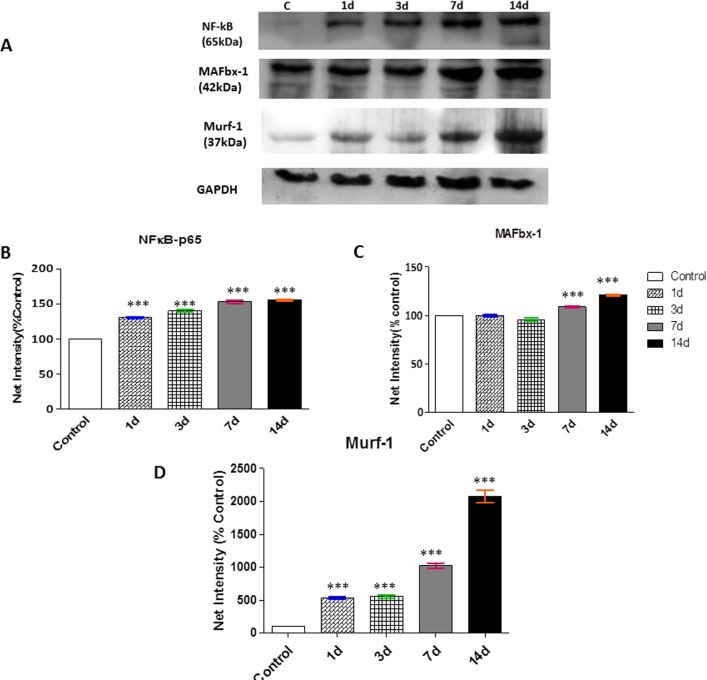
Upregulated NF-κB and E3 ligase mediated protein degradation in response to chronic hypoxia.(A) Representative western blots for expression of NF-κB and Mafbx-1 in skeletal muscles and (B—D) Semiquantitative analysis of the expression of NF-κB, MAFbx-1and MuRF-1 is presented in the graph. The densitometric analysis is shown as mean ± SEM performed in n = 3 independent experiments. *p<0.05 Vs. Control; **p<0.01 Vs. Control; ***p<0.001 Vs. Control.